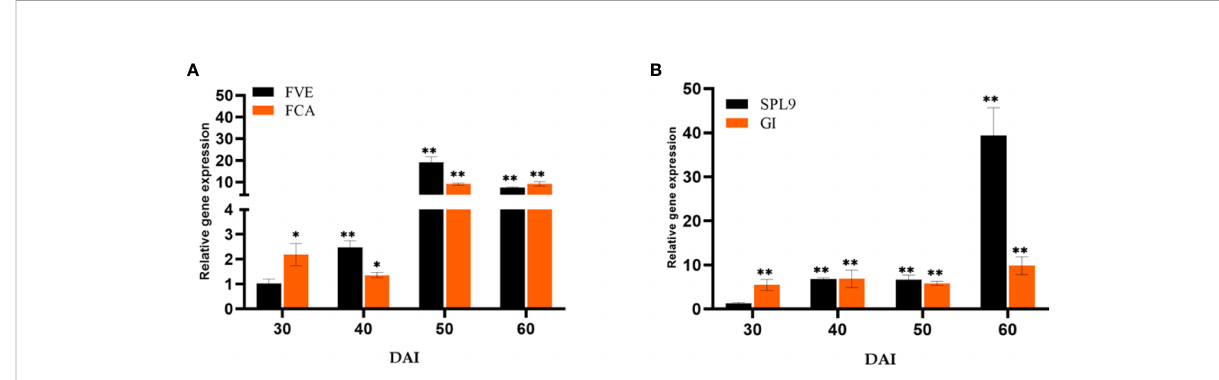
FIGURE 7 Relative expression of genes in the (A) autonomous pathway (FVE & FCA) and (B) age pathway (SPL9 & GI) respectively, responsible for fl oral induction. qRT-PCR was carried out with samples isolated at 30, 40, 50 and 60 DAI. Error bars shows ±SEs of three biological replicates. student t - test determined signi fi cance of gene expression ** P< 0.01 and * P < 0.05.